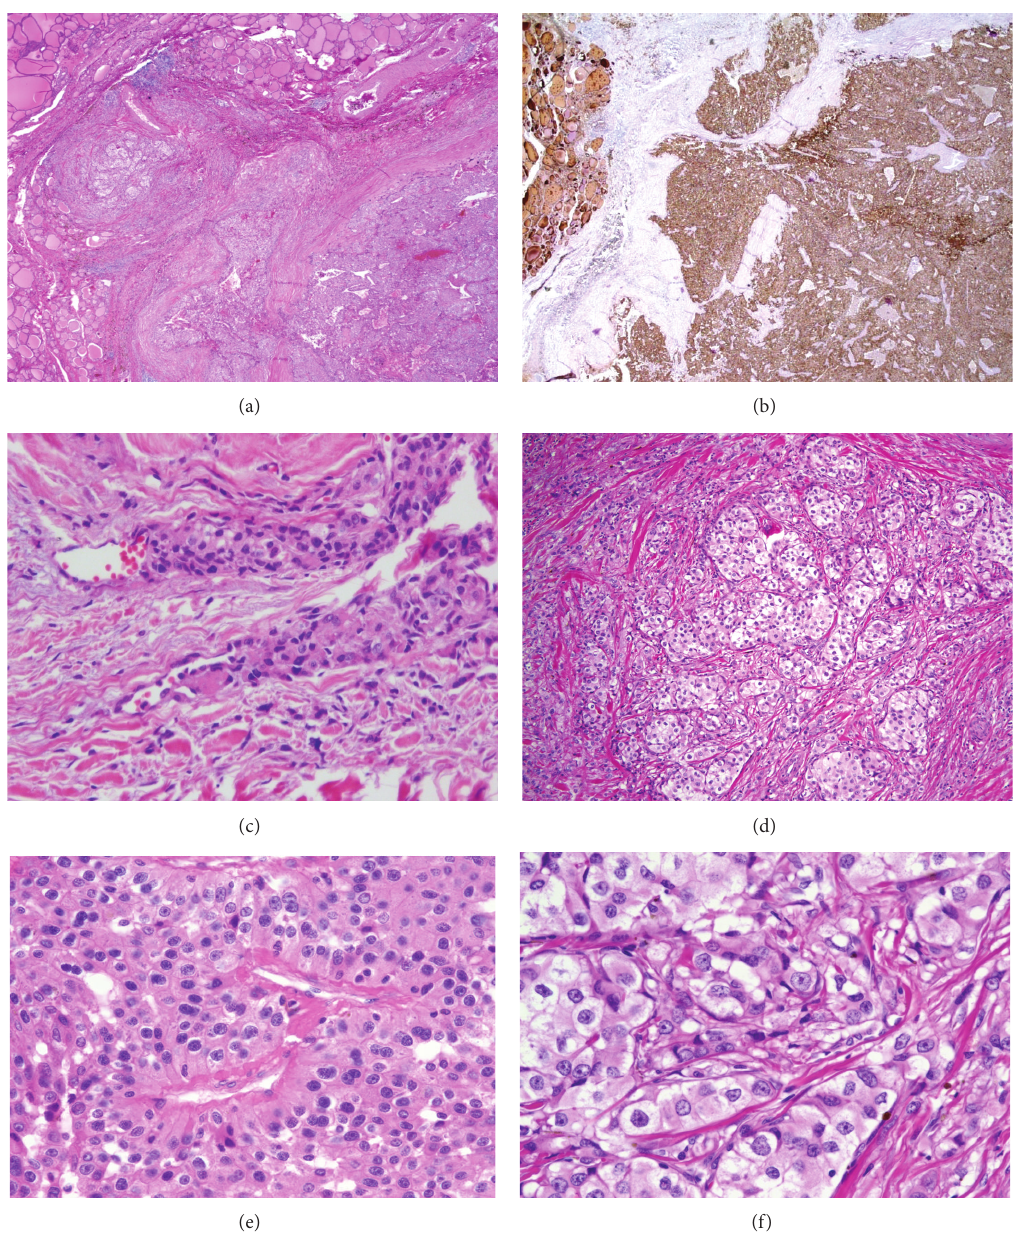
Figure 2: Microscopic appearance of intrathyroidal parathyroid carcinoma. (a) Extracapsular extension (“mushroom projection”) of neoplastic cells through the capsule into surrounding thyroid parenchyma (hematoxylin and eosin stain (H&E); magnification 20x). (b) Immunohistochemistry for parathyroid hormone (PTH) shows strong and diffuse immunoreactivity in tumor cells and highlights areas of capsular invasion. There is nonspecific staining of colloid in thyroid follicles in the upper left (20x). (c) Foci of vascular invasion seen at the periphery of the tumor (H&E; 100x). (d) Trabecular arrangement of tumor cells traversed by thick bands of collagen (H&E; 40x). (e) Focal perivasculararrangementoftumorcellsaroundvessels(H&E;200x).(f)Cytologicfeaturesoftumorcellsdemonstratingtumorcellmonotony with clear to eosinophilic cytoplasm and prominent macronucleoli (H&E;